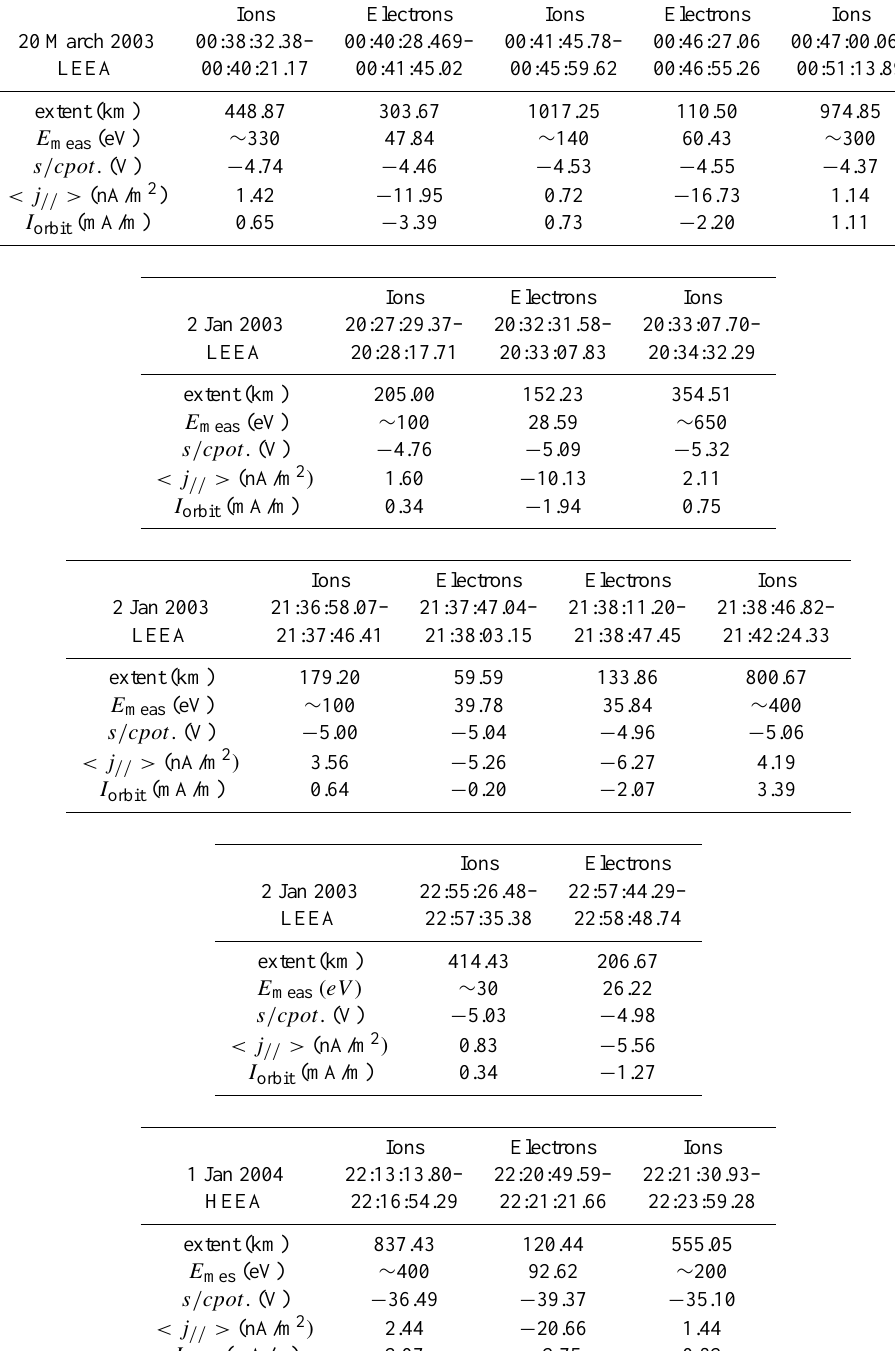
Table 1. Characteristic magnitudes of the upgoing particle acceleration structures for different events including the spatial extent of the structure along the satellite trajectory, the measured energy E meas of the beam distribution function maximum, the spacecraft potential, the current density <j // > averaged over the structure and the current intensity I orbit